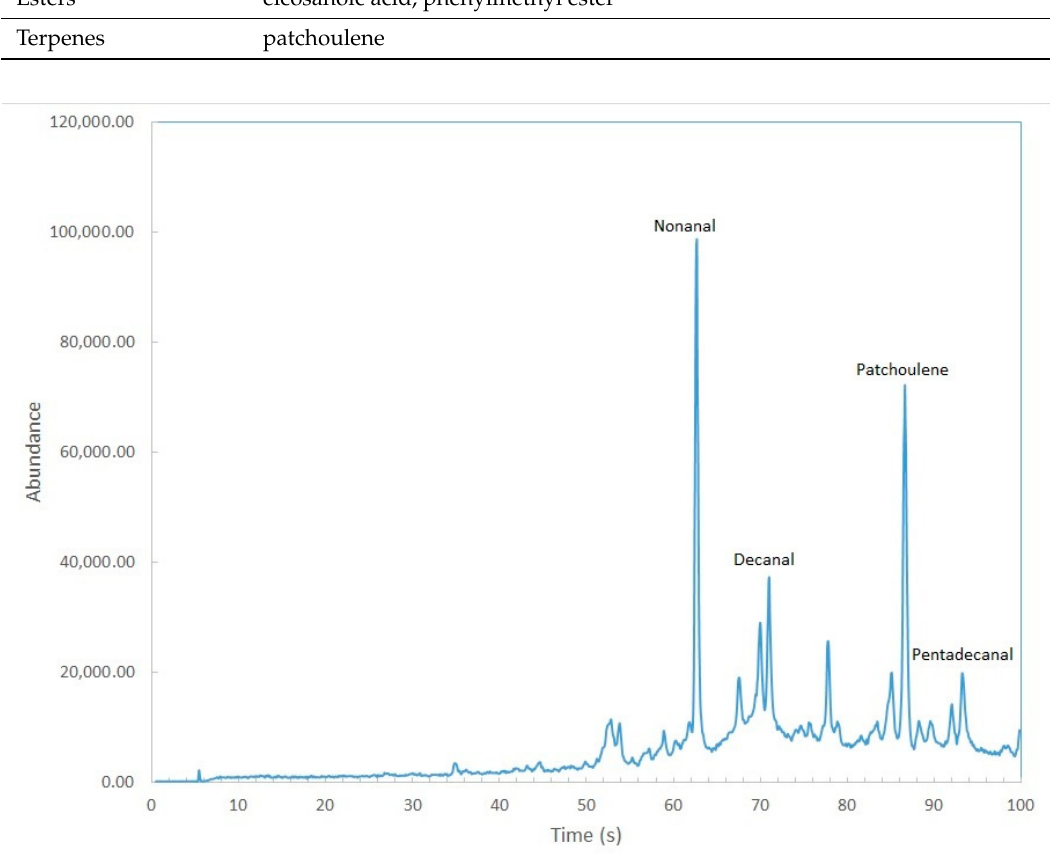
Figure 3. Chromatogram obtained at a kiln temperature of 65 °C. Table 2. Compounds commonly identified during malting.